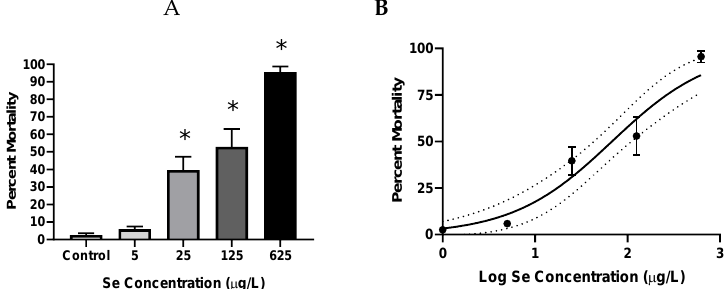
Figure 1. Mean ( ± SE) percent cumulative mortality (1–5 dpf) of zebrafish exposed to increasing concentrations of SeMet via embryo aqueous exposure. ( A ) Bar graph, asterisks represent significant differences compared to the control using a Kruskal–Wallis one-way analysis of variance (ANOVA) by ranks followed by a Dunn’s multiple comparisons test ( p < 0.05); n = 8–12 replicates of 20 embryos. ( B ) Dose-response curve used to calculate the LC 50 value of 67.9 µ g / L (95% CI = 43.4–108 µ g / L). Dotted lines represent the 95% confidence